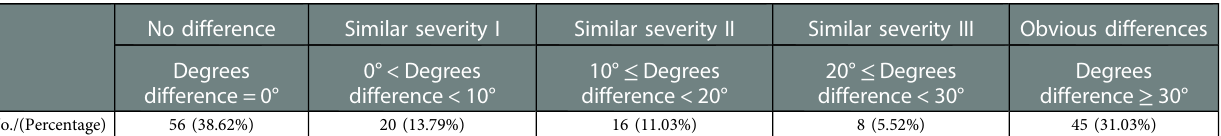
TABLE 4 Differences in the right and left hands pronation degree in patients with bilateral